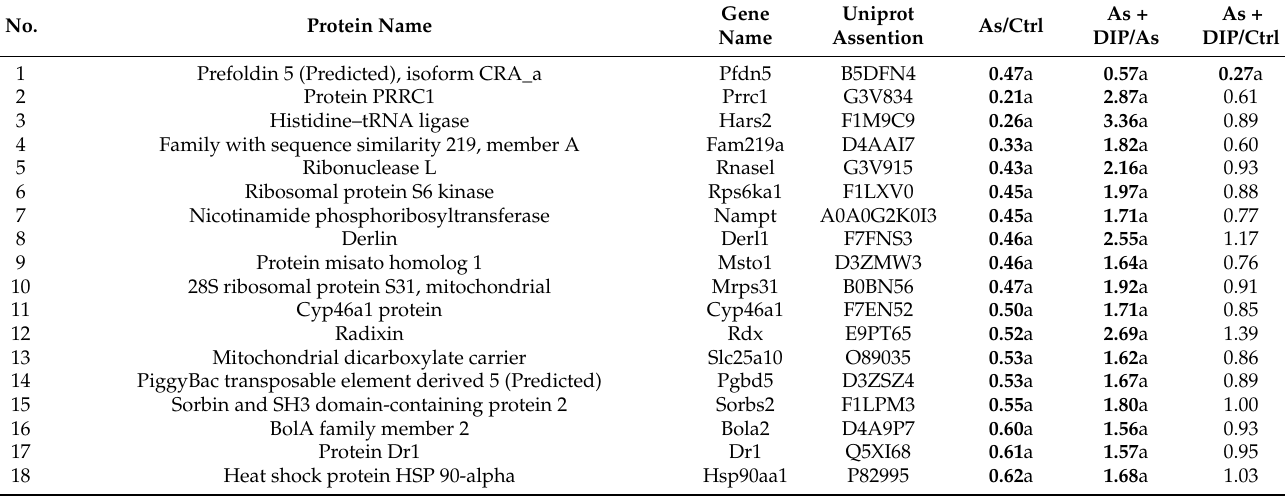
Table 1. Reversed proteins Identified in the present